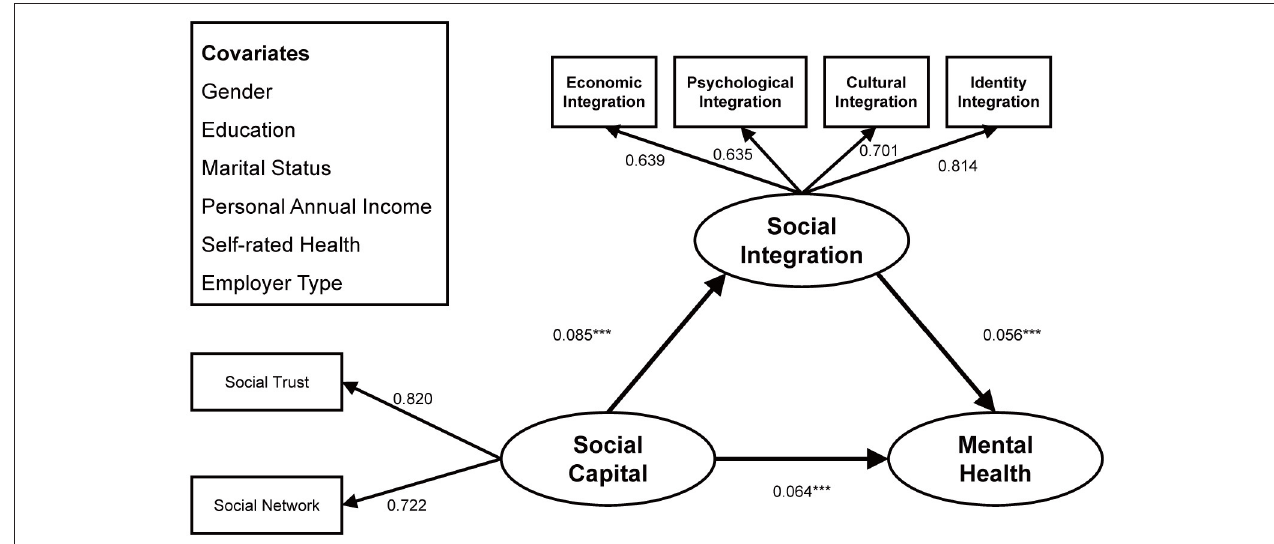
FIGURE 5 | Standardized structural model (sub-sample: 51–64 years old). *** p <